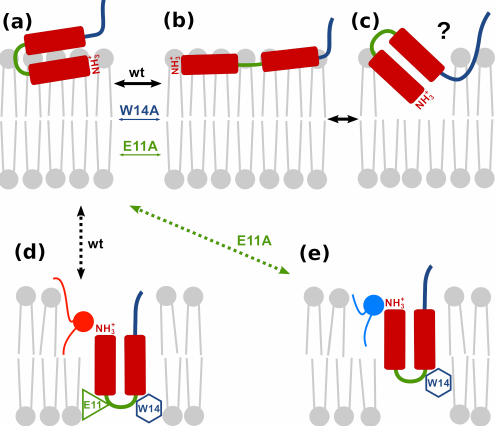
Figure 9. Possible insertion modes of HAfp into lipid membrane: ( a , b ) surface hairpin and boomerang, respectively; ( c ) obliquely inserted hairpin; ( d ) deeply inserted transmembrane hairpin (wt); and ( e ) shallowly inserted transmembrane hairpin